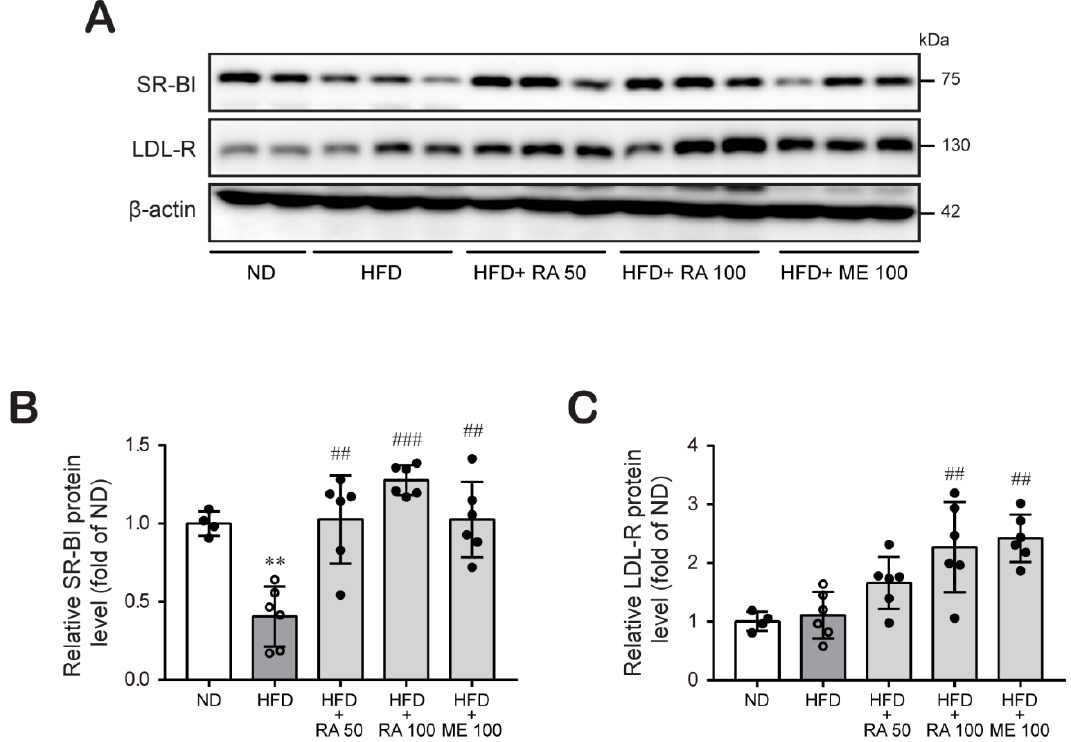
Figure 3. RA induces hepatic LDL-R and SR-BI protein expression in HFD-fed mice. ( A – C ) Liver tissues were lysed, and the levels of proteins regulating hepatic lipid uptake, LDL-R ( A , B ) and SR-BI ( A , C ), were examined by western blot analysis. β -actin was used as a loading control. Band densities were quantified, and the relative protein levels are presented as the mean ± SD ( n = 4–6). ** p < 0.01 vs. ND control mice; ## p < 0.01, ### p < 0.001 vs. HFD mice.